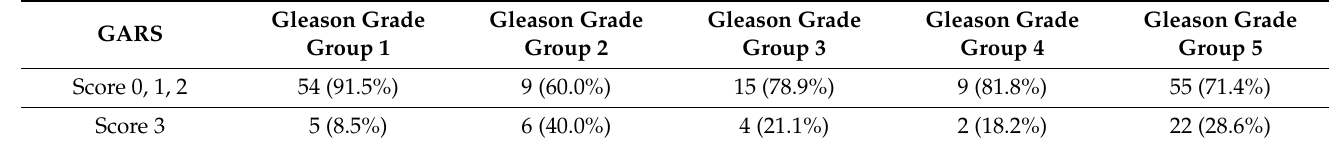
Table 1. GARS expression in relation to patient’s Gleason Grade